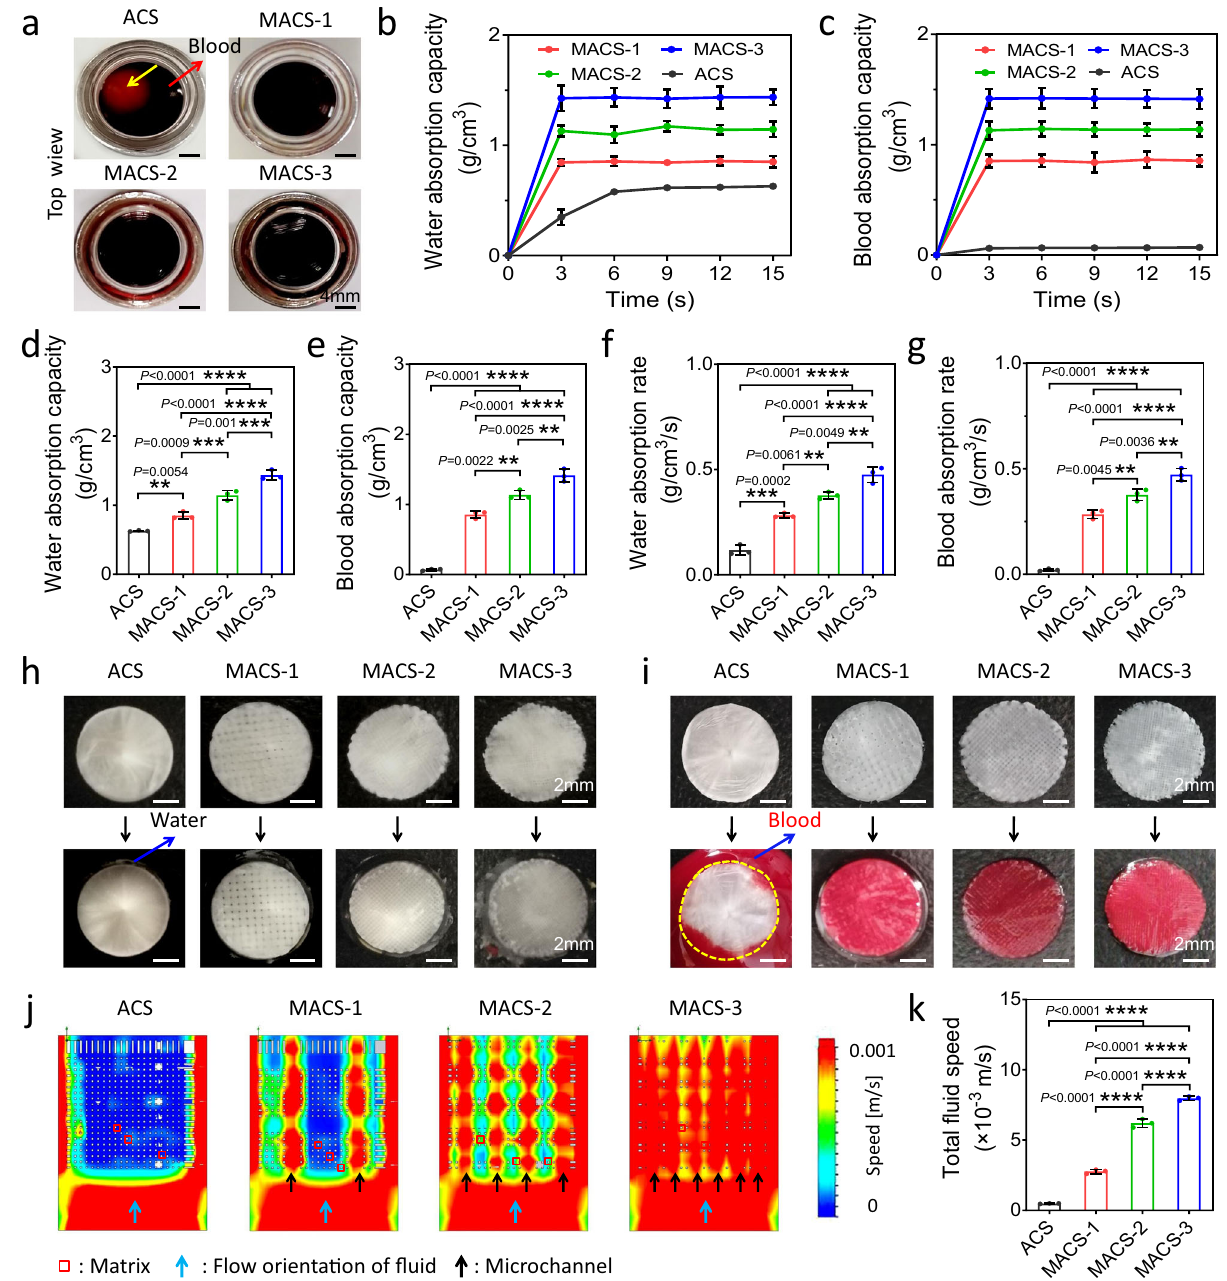
Fig. 3 Water/blood absorbability of the ACS and MACSs. a Macro photograph of the ACS and MACS-1/2/3 after absorbing the blood. Yellow and red arrows represented the ACS and blood, respectively. b , c Water/blood absorption capacity-time dynamic curves of the ACS and MACS-1/2/3. d – g Water/ blood absorption capacity and rate of the ACS and MACS-1/2/3. h , i Macro photographs of the compressed ACS and MACS-1/2/3 before and after contact with water and blood. The yellow dotted circle represented the boundary of the ACS. j Fluid simulation images of water absorption behaviors of the ACS and MACS-1/2/3. k Total fl uid speed of the ACS and MACS-1/2/3. n = 3 independent samples. Data are expressed as mean ± SD. The signi fi cant difference was detected by one-way ANOVA with Tukey ’ s multiple comparisons test. The ‘ ns ’ indicated no signi fi cant difference, **P < 0.01, ***P < 0.001, ****P <